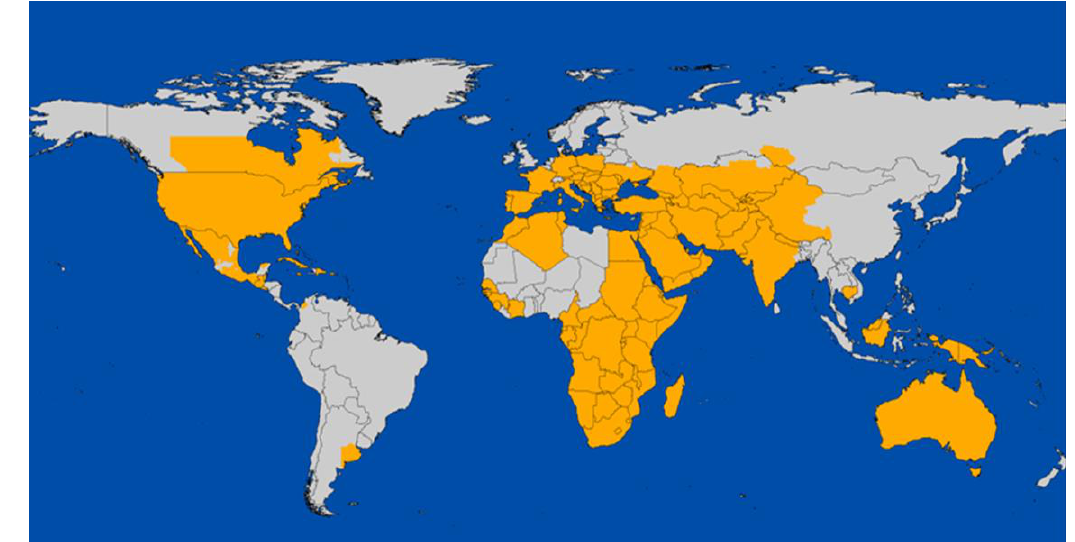
Figure 1. Global distribution of West Nile virus, 2006 [Figure courtesy of the US Centers for Disease Control and